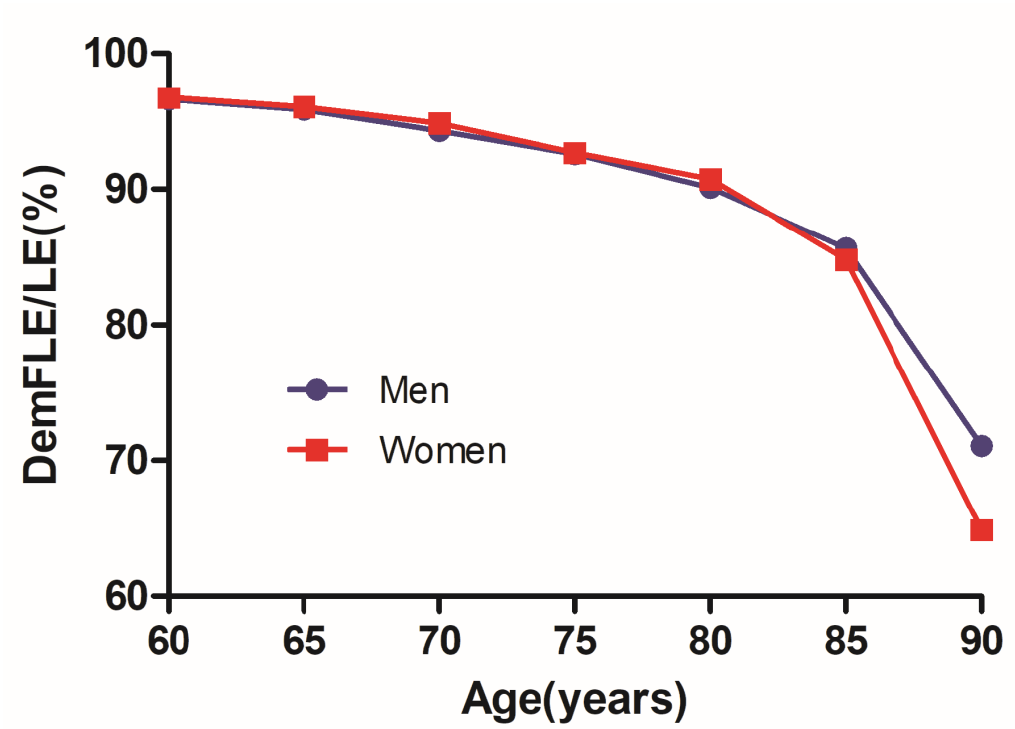
Figure 2. Trends of dementia-free life expectancy as a proportion of life expectancy (DemFLE / LE) for men and women.